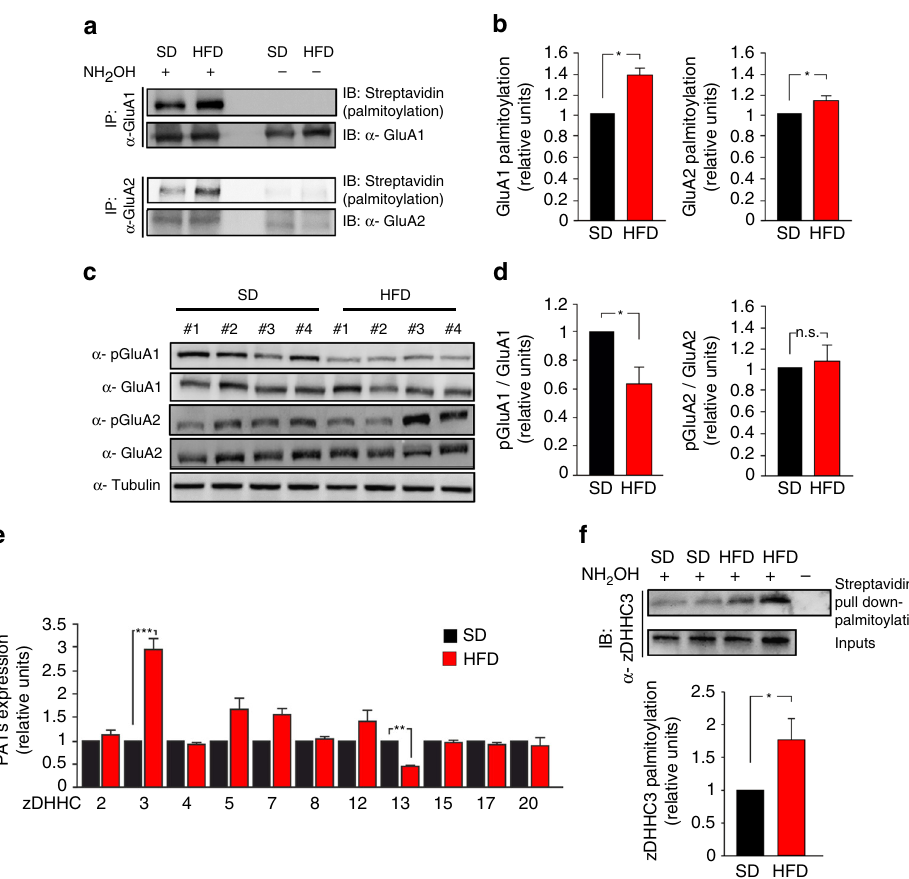
Fig. 2 HFD increases palmitoylation and inhibits phosphorylation of GluA1. a Palmitoylation of GluA1 and GluA2 was examined in the hippocampus of SD and HFD mice using a modi fi ed biotin switch assay (ABE, see "Acyl-biotinyl exchange assay" section in Methods). Immunoblot showing palmitoylated (acyl-biotinyl exchanged and detected by streptavidin) GluR (top) and total immunoprecipitated protein (bottom). Samples without NH 2 OH are negative controls. b Densitometry of palmitoylated GluA1/total immunoprecipitated GluA1 (left, n = 6) and palmitoylated GluA2/total immunoprecipitated GluA2 ratio (right, n = 4; statistics by Mann – Whitney test). c Immunoblots of hippocampal homogenates revealing reduced phosphorylation of GluA1 at serine 845 (pGluA1 Ser 845 ) in HFD mice, and unchanged phosphorylation of GluA2 at serine 880 (pGluA2 Ser 880 ). Samples were harvested from two independent experiments. d Densitometry of pGluA1 Ser 845 (left) and pGluA2 Ser 880 (right) blots normalized to both the corresponding total protein and tubulin ( n = 10 mice per group; statistics by unpaired Student ’ s t -test). e Expression of zDHHC 2, 3, 4, 5, 7, 8, 12, 13, 15, 17, and 20 mRNA, assessed by Real-Time qPCR. Gene expression was normalized to actin. Data represent mean values obtained from fi ve mice for each group; experiments were performed in triplicate (statistics by unpaired Student ’ s t- test). f Immunoblots showing palmitoylation (Streptavidin pull down-palmitoylation also named “ proteomic ABE ” , see Methods) (top) and expression (middle) of zDHHC3 in the hippocampus of SD and HFD mice. Samples without NH controls. Densitometry (bottom) of palmitoylated zDHHC3/total protein ( n = 6; statistics by Mann – Whitney test). Data are expressed as mean ± s.e.m. * p < 0.05; ** p < 0.01; n.s. not signi fi cant. See also Supplementary Fig.